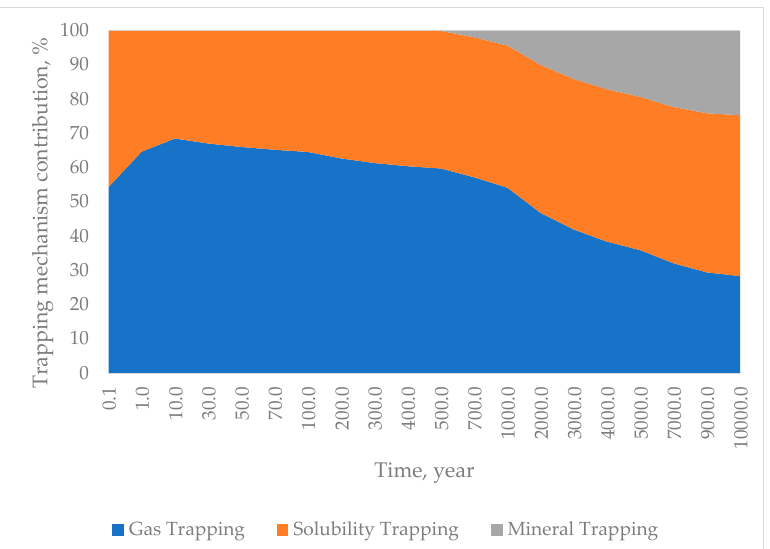
Figure 10. Graph showing contribution of different trapping mechanisms for homogenous case through time.